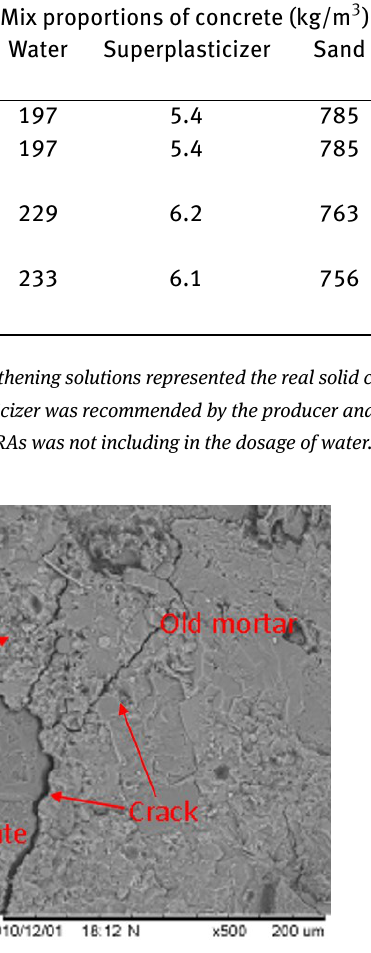
Figure 1: Micro-morphology of ITZ in recycled aggregate of Speci- men A0